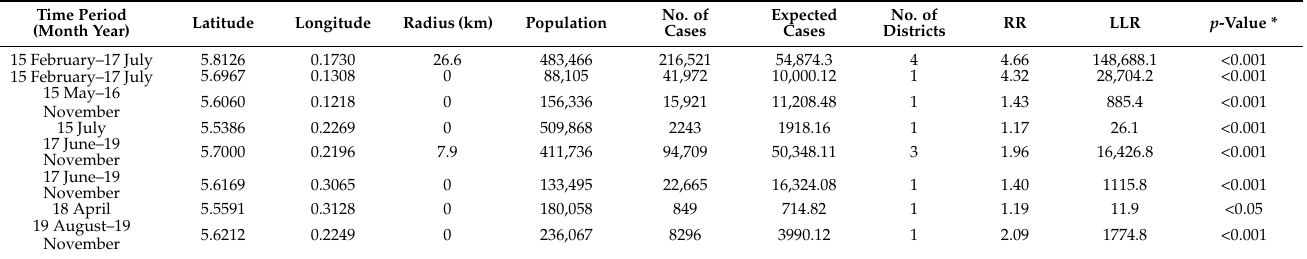
Figure 5. A significantly high rate of spatio-temporal malaria clusters with Kulldorff’s space–time scan statistic in the Greater Accra Region, 2015–2019. Table 1. The date range and location of space–time clusters of malaria incidence in the Greater Accra Region, 2015–2019.